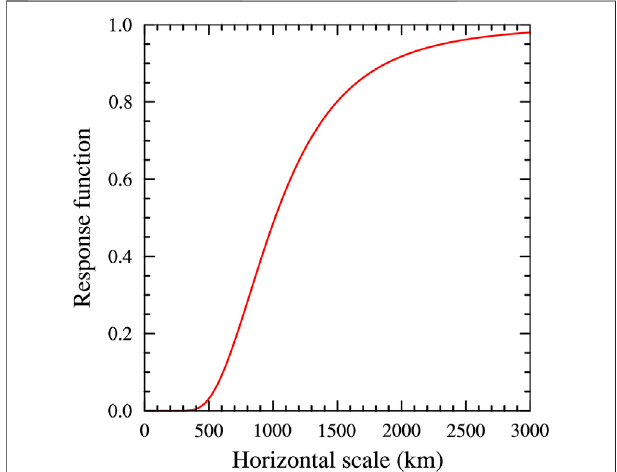
FIGURE 8 | The response function of the Barnes-type fi